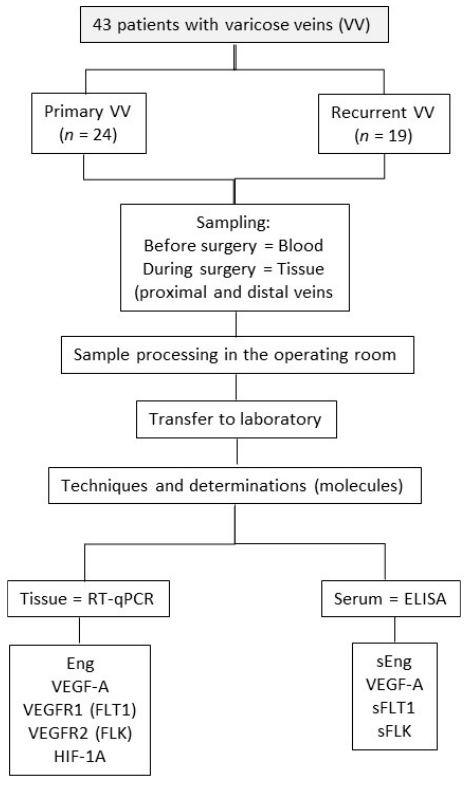
Figure 1. Scheme of the investigation. RT-qPCR, reverse transcription polymerase chain reaction; ELISA, enzyme-linked immunosorbent assay; Eng, endoglin; VEGFA, vascular endothelial growth factor A; VEGFR1, vascular endothelial growth factor receptor 1 (or FLT1); VEGFR2, vascular endothelial growth factor receptor 2 (or FLK), HIF1A, hypoxia-inducible factor 1A. Note: FLT1 and FLK were not determined in the samples of distal veins.